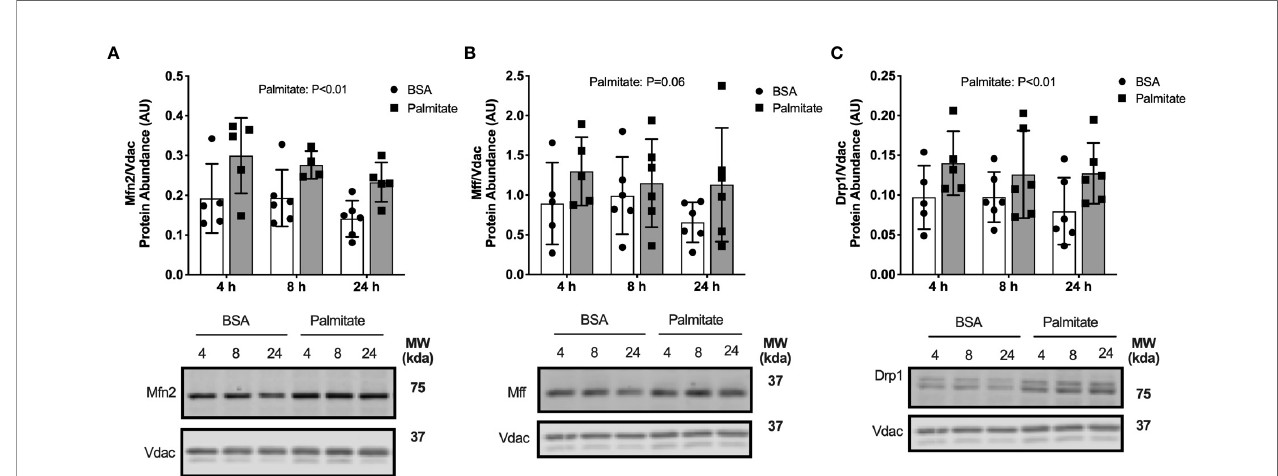
FIGURE 6 | Palmitate treatment in myotubes activated fusion/ fi ssion. Fusion and fi ssion markers in C2C12 myotubes treated with palmitate for 4, 8, or 24 hours. Cell lysates were fractionated to prepare a mitochondrial-enriched fraction for immunoblotting for Mitofusion 2 (Mfn2) (A) , mitochondrial fi ssion factor (MFF) (B) and DRP1 (C) . Images below graphs are representative blot images. Protein targets in the mitochondrial fraction are normalized to Vdac abundance as a mitochondrial protein control. Panels (B, C) contain the same Vdac image because the targets are from the same membrane. Data are means ± SD; n=5-6. Two-way ANOVA was used to test for effects of diet and time. P values are main